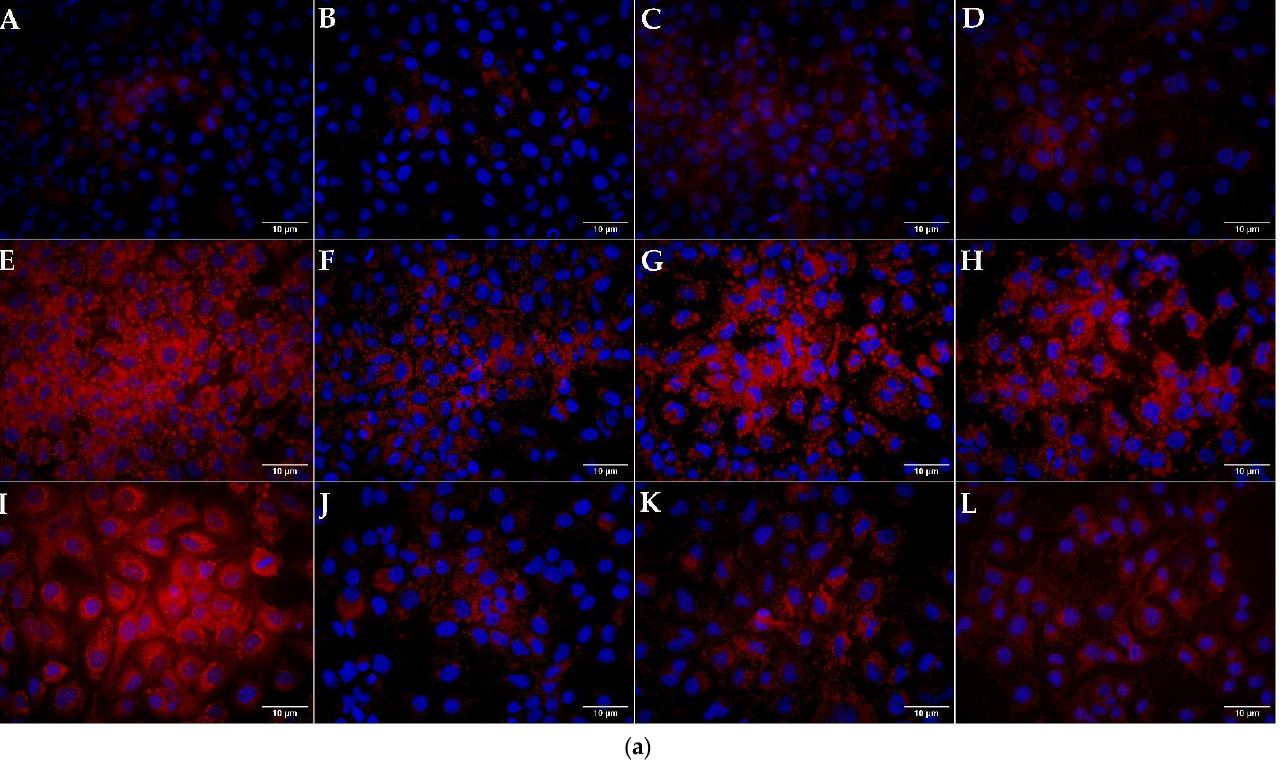
Figure 3. Cont . Figure 3. Cont